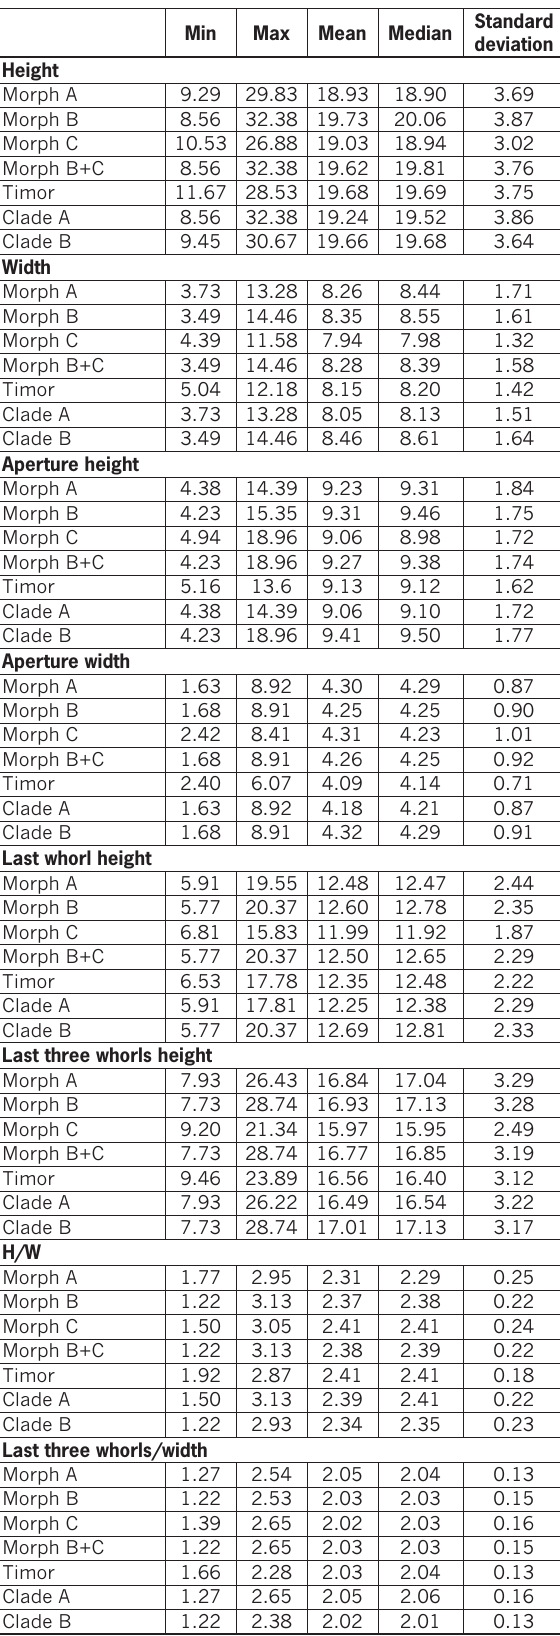
Table 2. Biometric data for different shell morphs/geograph - ic groups (see also Figs 2, 8, 9) and mitochondrial clades (see Figs 4, 8, 9) of Tarebia granifera (Lamarck,